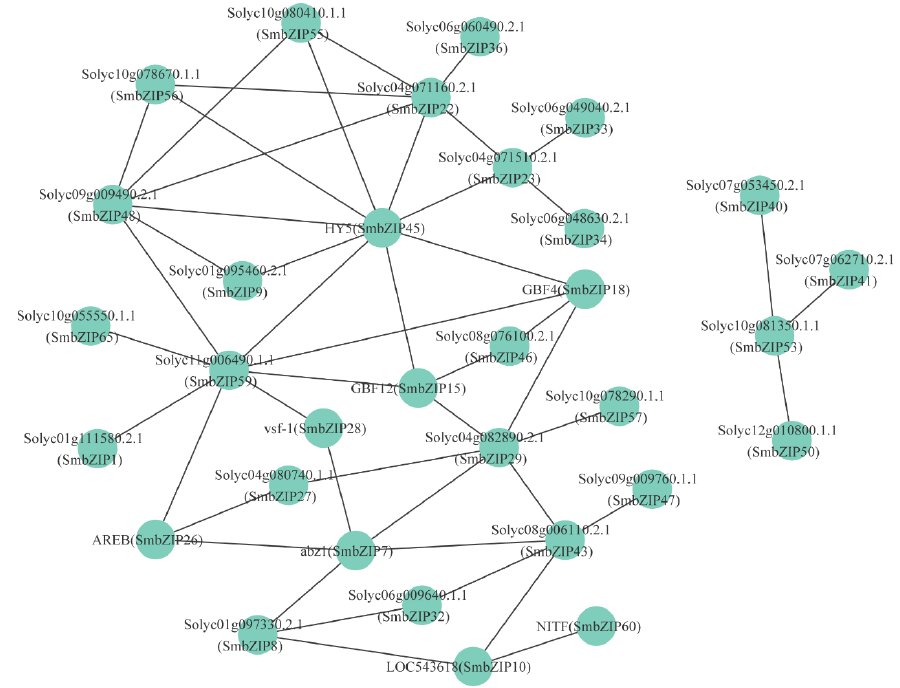
Figure 6. Functional interaction network of SmbZIP proteins in eggplant according to orthologues in S. lycopersicum